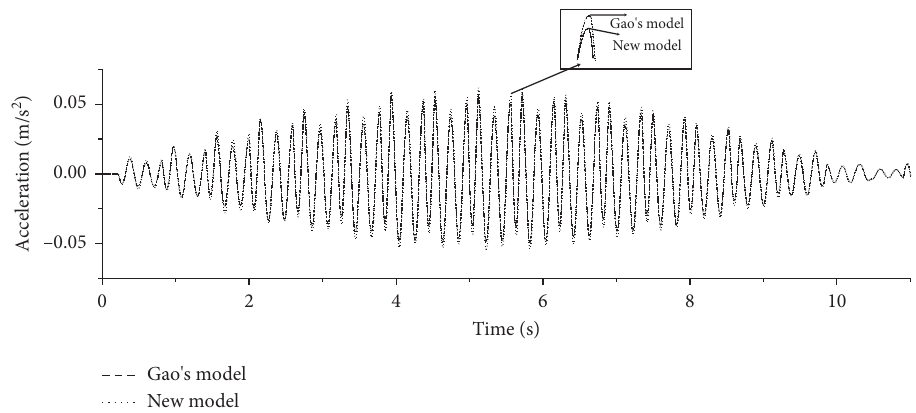
Figure 7: Acceleration at beam mid-span (initial vector optimized).